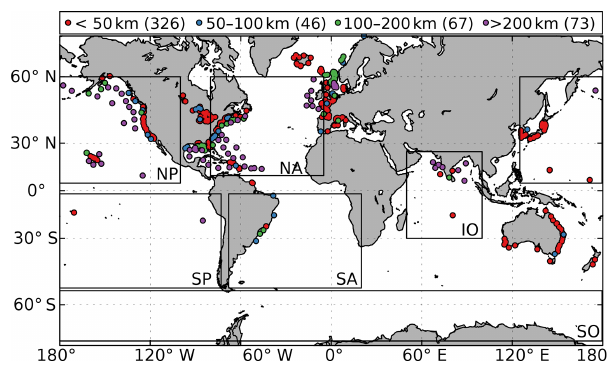
Figure 1. Global maps of the wave in situ data used to validate the Sea State CCI dataset v1. Red circles indicate stations less than 50km from the coast, blue circles indicate stations between 50 and 100km from the coast, green circles indicate stations between 100 and 200km from the coast, and pink circles indicate stations more than 200km from the coast. The number of stations is given within brackets. Black boxes indicate basin extensions used for the re- gional validation of the